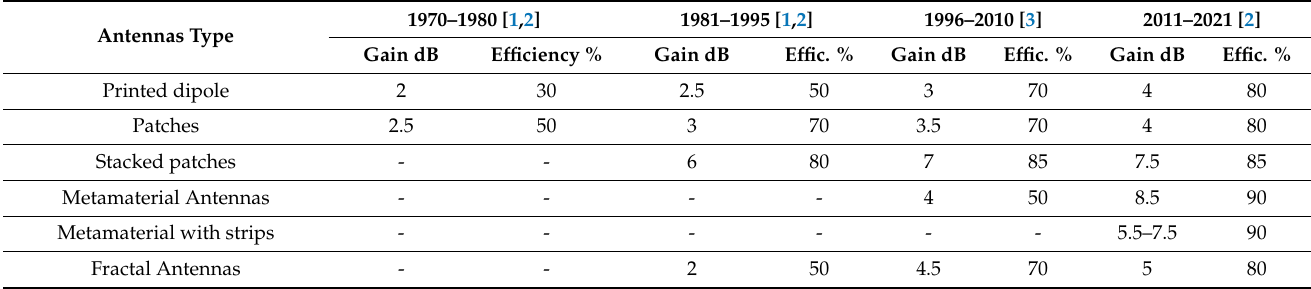
Table 1. Small Antennas Gain and efficiency Comparison, 1970–2021.